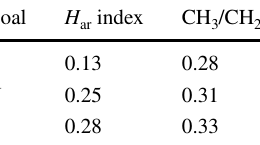
Table 7 The molecular FTIR spectral indexes for pyrolysis tars